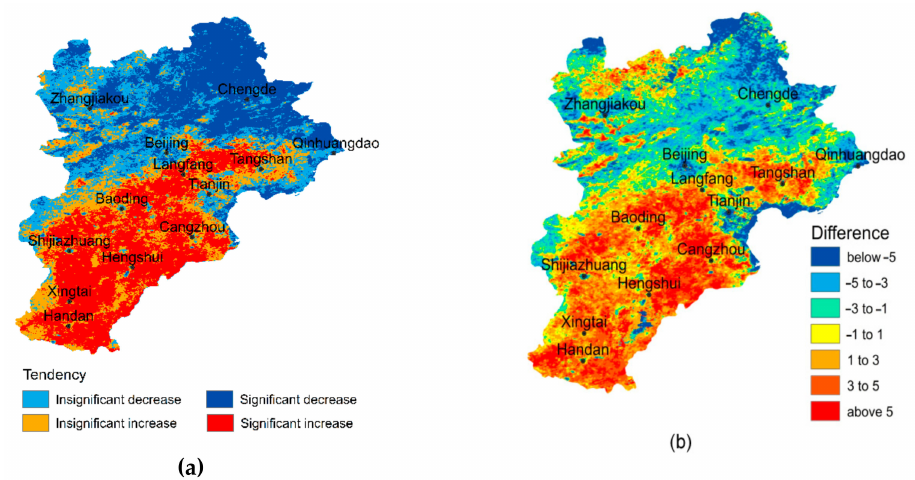
Figure 3. The tendency and di ff erence of surface urban heat island intensity (SUHII) at each pixel: ( a ) The tendency of SUHII variation from 2001 to 2015, and ( b ) the di ff erence of SUHII between 2001 and 2015. The tendency was checked with the M-K test at the 95% confidence level, and categorized into four levels, according to the Z value: 1) significant decrease (Z < − 1.64); 2) insignificant decrease ( − 1.64 ≤ Z < 0); 3) insignificant increase (0 < Z ≤ 1.64); and 4) significant increase (Z >